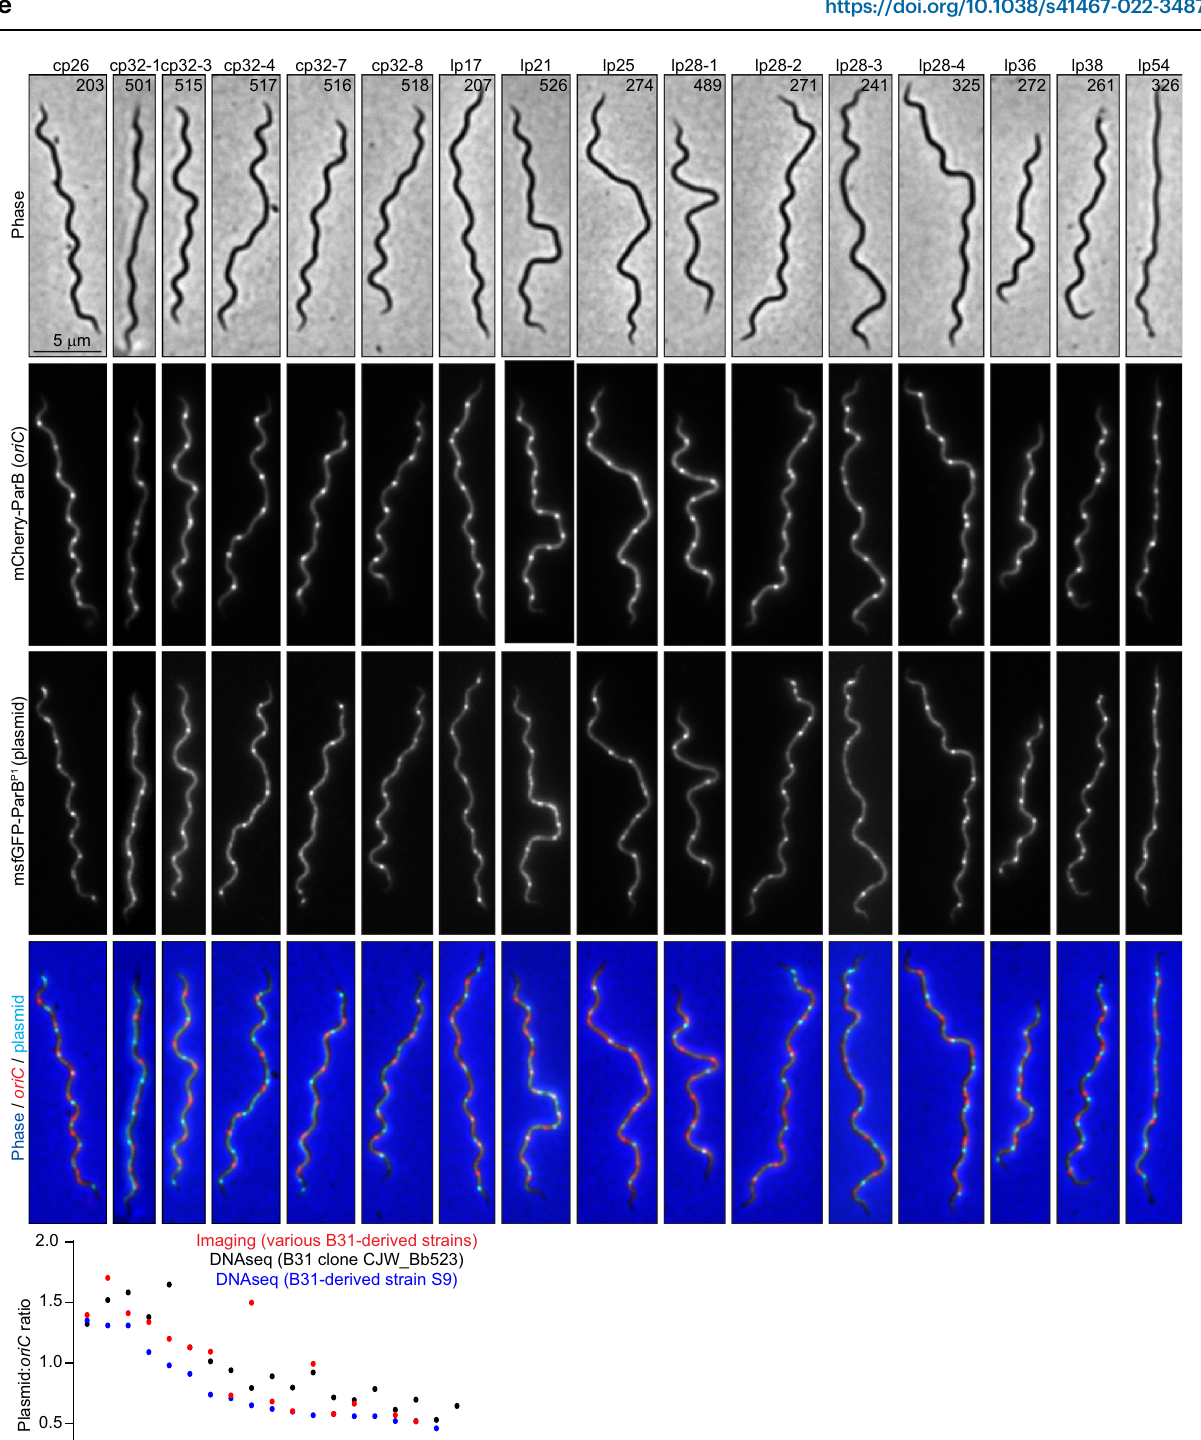
strains shown in ( a ) (red), or by marker frequency analysis of whole genome sequencing data (see methods) in strains S9 (blue) or strain CJW_Bb523, a clone ofstrainB31MI(black).SourcedataareprovidedasaSourceData fi le.Thenumbers ( n ) of cells analyzed and the number of replicates are provided in Supplemen- tary Data